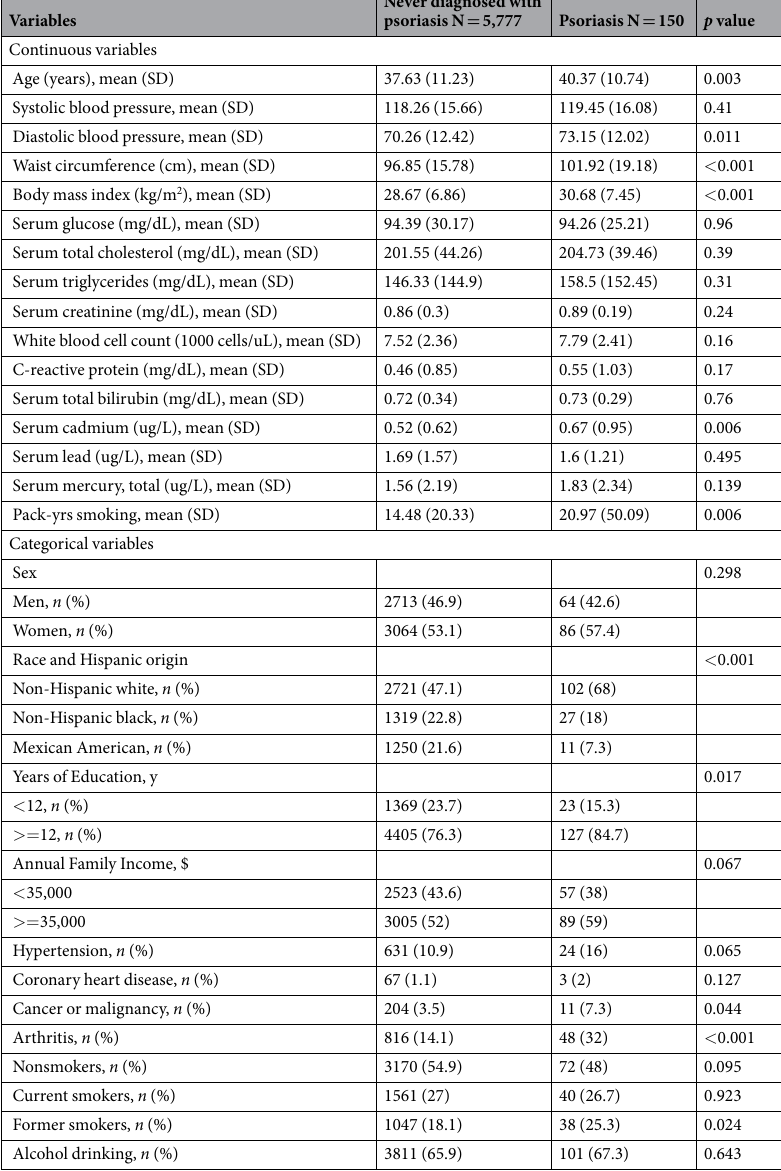
Table 1. Characteristics of study